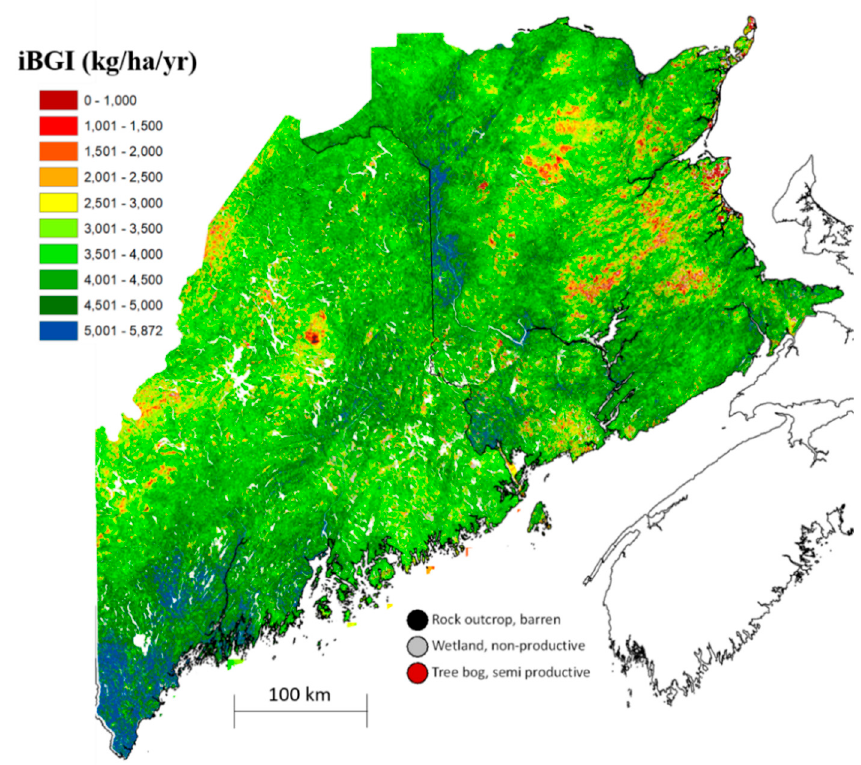
Figure 4. Improved biomass growth index (iBGI; kg ha − 1 year − 1 ) map estimated at 20 m resolution over the study area.